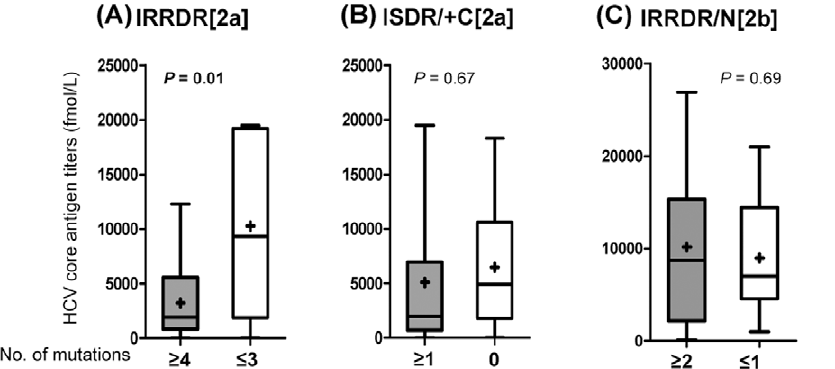
Figure 4. Correlation between NS5A sequence heterogeneity and pretreatment serum HCV core antigen titers in HCV-2a and HCV- 2b infections. Pretreatment serum HCV core antigen titers of patients classified on the basis of the number of mutations in IRRDR[2a] (interferon/ ribavirin resistance-determining region of HCV-2a) ( $ 4 vs. # 3) (A), ISDR/ + C[2a] (part of interferon sensitivity determining-region plus its carboxy- flanking region of HCV-2a) ( $ 1 vs. =0) (B) and IRRDR/N[2b] ( $ 2 vs. # 1) (an N-terminal part of interferon/ribavirin resistance-determining region of HCV-2b) (C) are depicted. Maximum and minimum values are indicated by the upper and lower bars, respectively. Distribution ranges are displayed as boxes. Mean and median values are also indicated inside the boxes as + and horizontal bars,